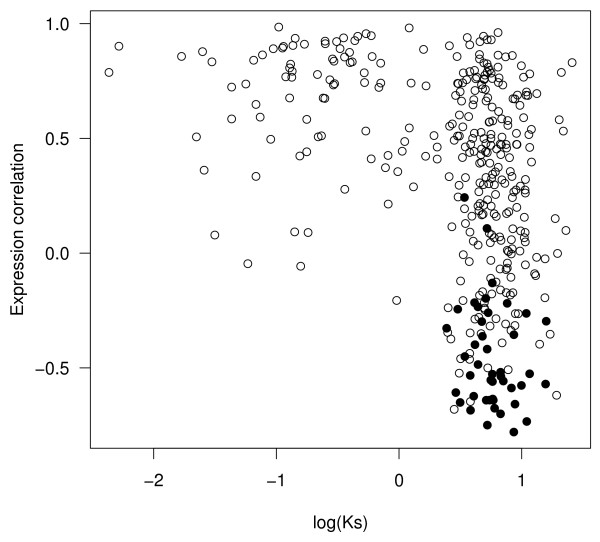
Temporal subfunctionalization. Observed temporal subfunctionalization in vivo for the "elutriation" time course dataset. Ks values calculated for each yeast paralog (see Methods – Analysis of yeast data) are plotted against the correlation coefficient of the expression values. Paralogs for which temporal subfunctionalization is observed are shown with filled circles, those for which none is found are shown with open circles.